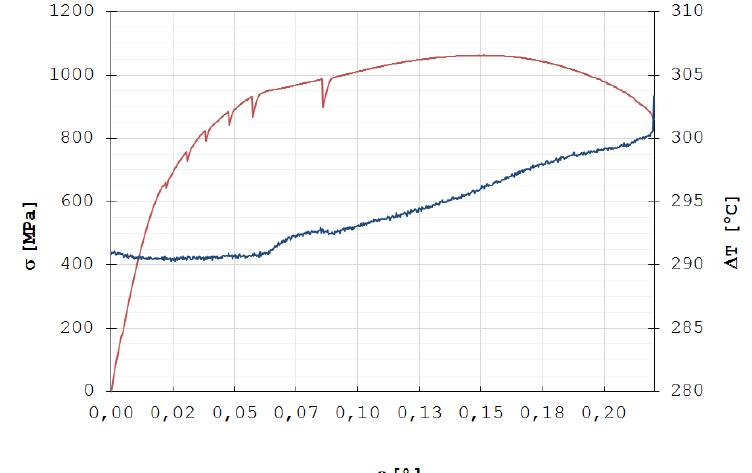
Figure 10: Stress vs strain curve and temperature trend of specimen 1 mono axial static